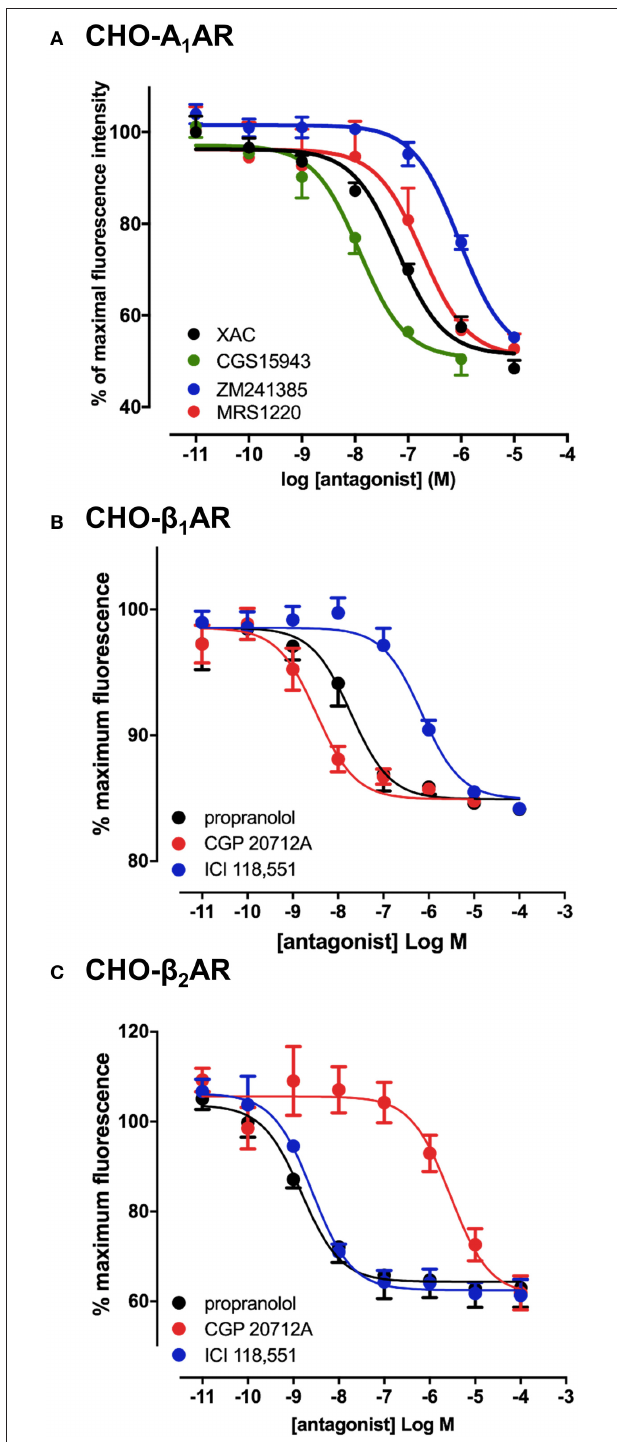
FIGURE 2 | Competition binding assays at the adenosine A 1 and β 1 / β 2 -adrenoceptors. CHO cell lines stably expressing A 1 AR (A) , β 1 AR (B) or the β 2 AR (C) were incubated with 25nM CA200645 (A 1 AR) or 10nM BODIPY-TMR-CGP ( β 1 AR and β 2 AR), in the absence or the presence of increasing concentrations of antagonists. Fluorescence intensity in each well was monitored using the PHERAstar FS. Values are mean ± SEM from 3–6 independent experiments performed in triplicate.